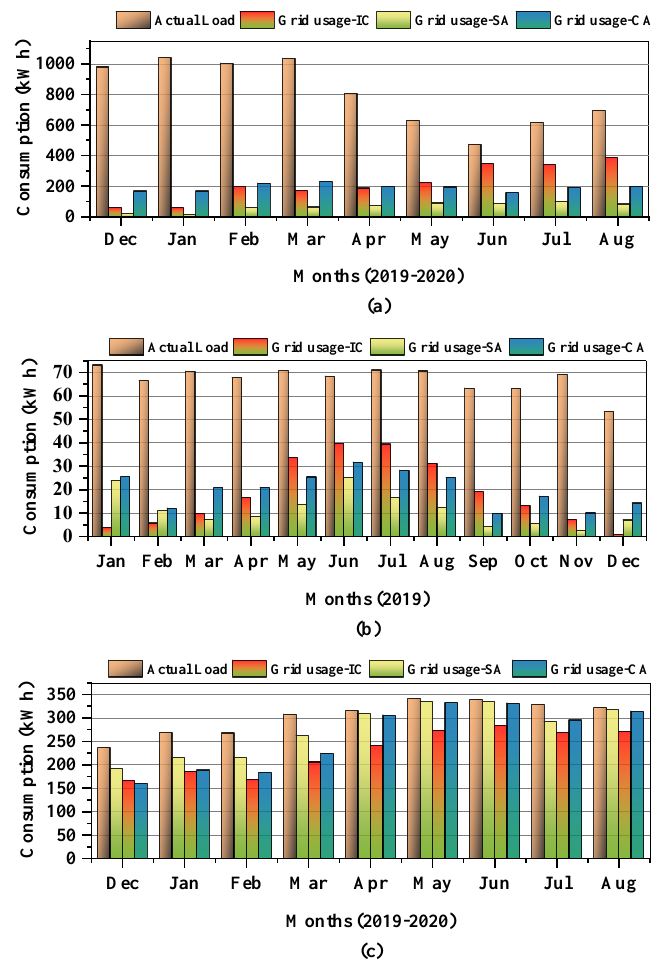
Figure 9. Comparison of actual CP load consumption with three strategies to analyze grid usage reduction: ( a ) Evermore, ( b ) Gen Y, and ( c ) SHAC.